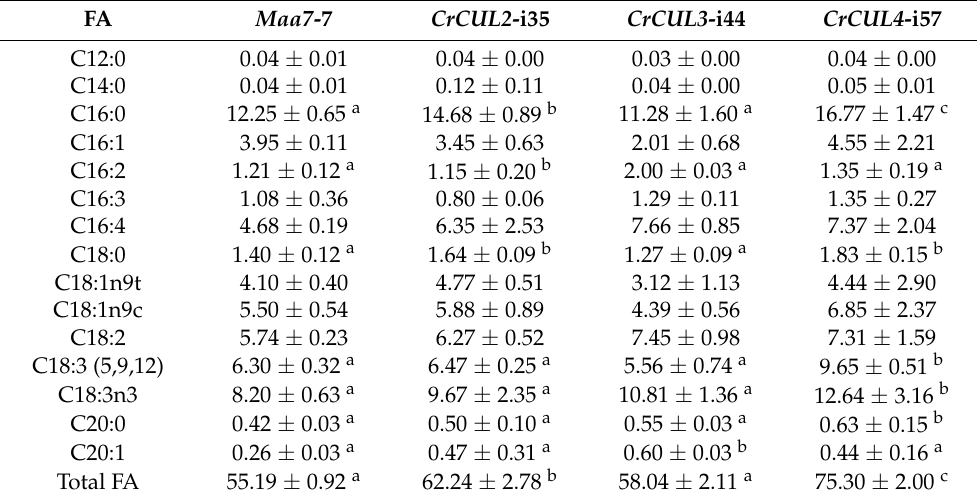
Table 2. FA content ( µ g/mg) of C. reinhardtii CrCUL RNAi